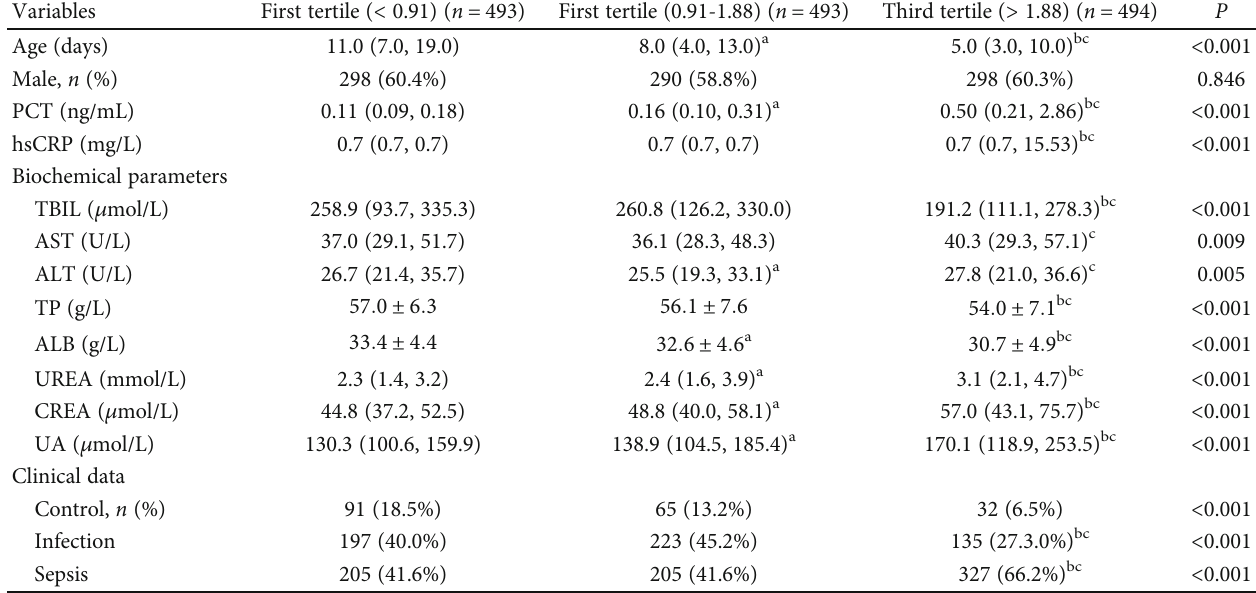
Table 2: Clinical and demographic characteristics according to NLR tertiles.